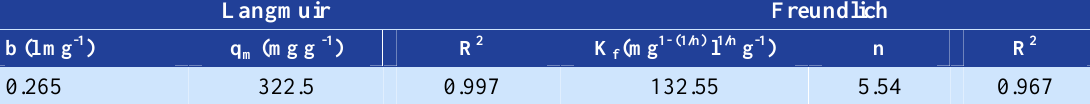
Table 1. Isotherm parameters of adsorption of Co(II) ions onto NiFe Langmuir